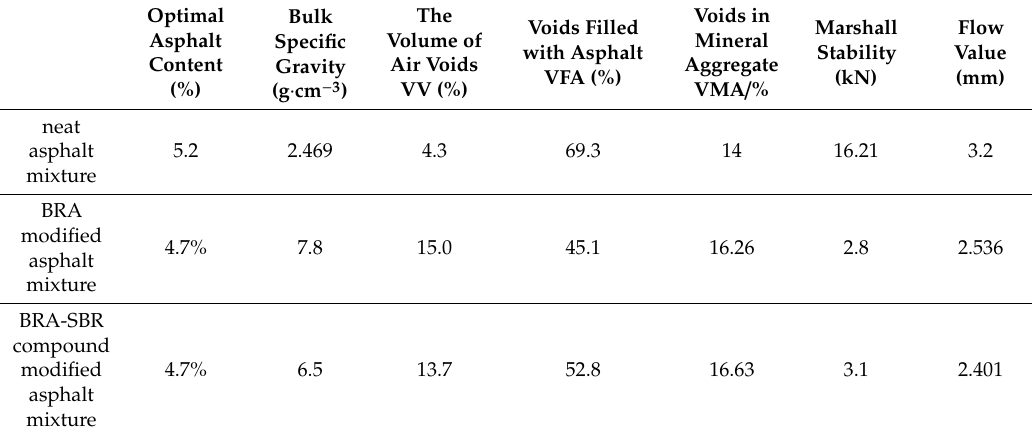
Figure 10. The aggregate gradation of AC-16C. Table 21. Marshall test results at optimal asphalt content.